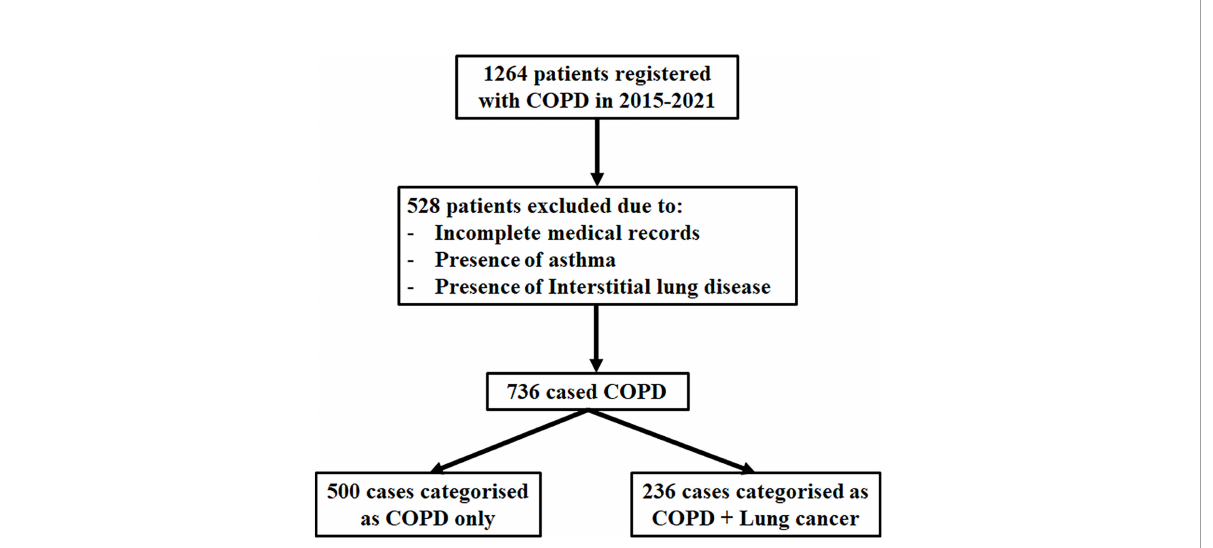
FIGURE 1 Flowchart of the population included in the study. Between 2015 and 2021, a total of 1,264 patients were retrospectively reviewed; 528 were excluded from the analysis due to missing medical records, asthma, and interstitial lung disease. The number of patients with COPD (FEV1/ FVC < 70%) was 736, which were eligible for this study. Of the 736 patients included, 236 cases had COPD with lung cancer, and 500 controls had COPD